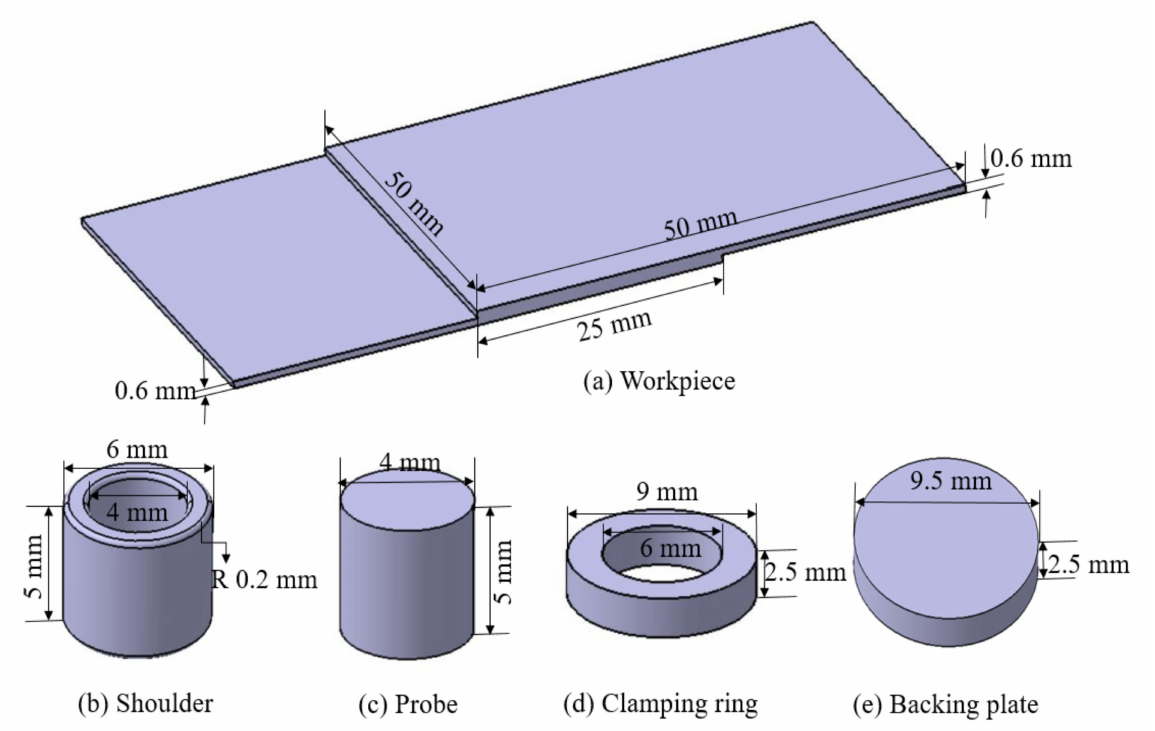
Figure 4. Geometries of modelled parts. ( a ) Workpiece; ( b ) shoulder; ( c ) probe; ( d ) clamping ring; ( e ) backing